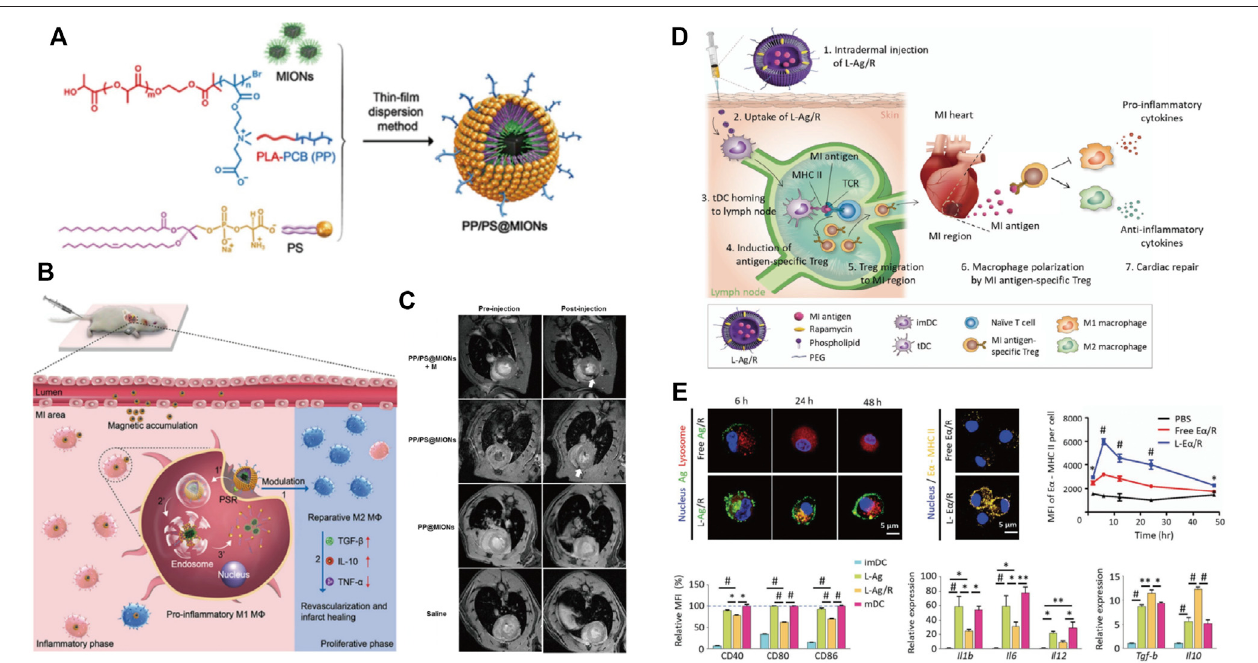
FIGURE 3 | Nanomaterials use immune-modulation strategy to treat MI. (A) Chemical construction of PP/PS@MIONs nanotheranostic system by the thin- fi lm dispersionmethod. (B) SchematicillustrationforPP/PS@MIONsinMI.PP/PS@MIONs wereaccumulatedintheMIareaduetomagnetictargetingandPStargetingand promoted thedifferentiation of thepro-in fl ammatory macrophages (M1) into thereparative macrophages (M2). (C) RepresentativeMR images ofhearts before and 24 h after i.v . administration ofPP/PS@MIONs and PP@MIONs withor withouta magnet. Adapted withpermissionfromChen et al., 2017. (D) Schematic illustration of MI treatment using liposomal nanoparticles loaded with MI-associated antigens and rapamycin (L-Ag/R). (E) The delivery of L-Ag/R promoted the antigen presentation ef fi ciency of DCs, inhibited the expressions of co-stimulatory surface molecules and pro-in fl ammatory cytokines expression in DCs, and increased the expressions of anti-in fl ammatory cytokines in DCs. Adapted with permission from Kwon et al., 2021.